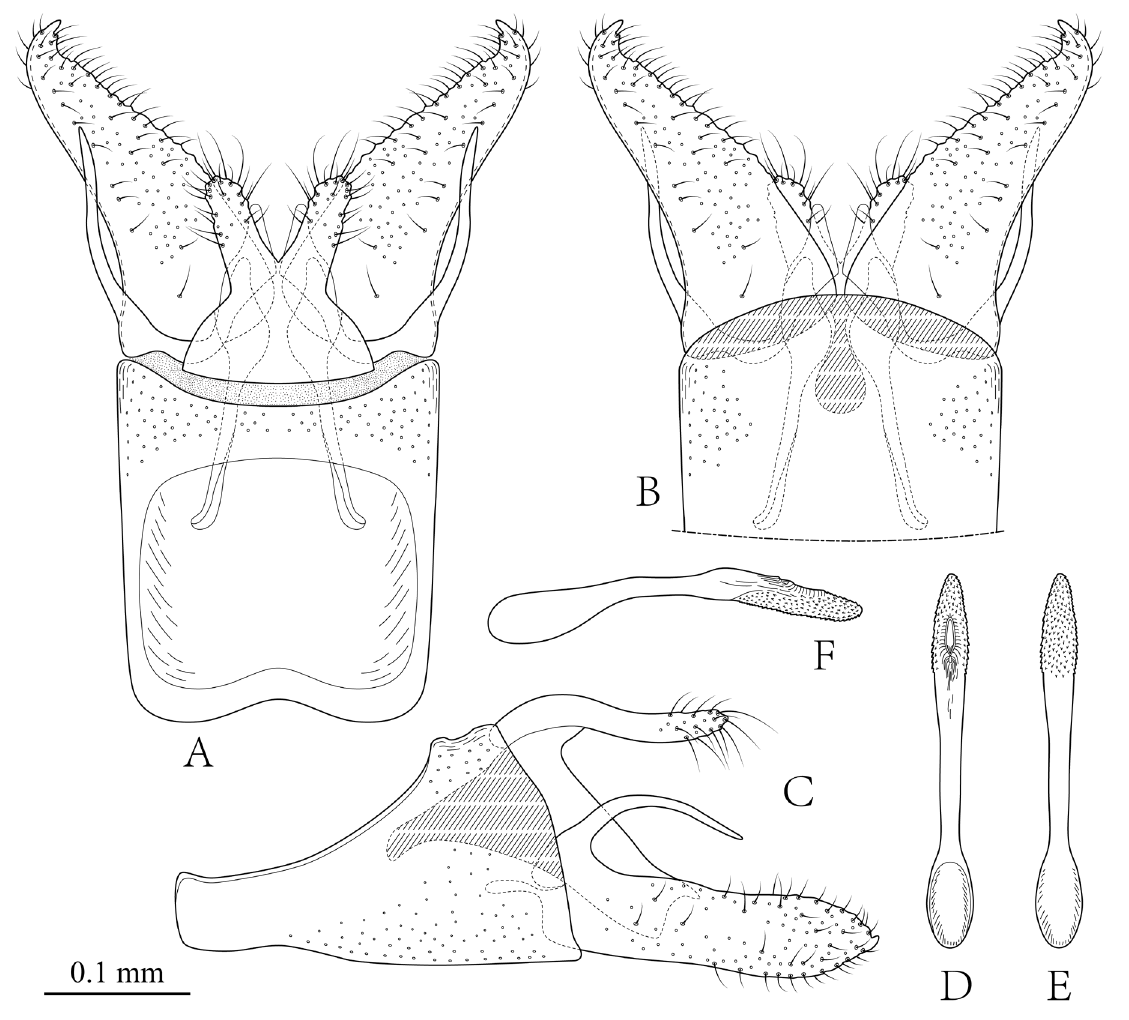
Fig. 4. Male genitalia of Vietomartyria maoershana sp. nov. A . Dorsal view, with phallus removed. B . Ditto , ventral view. C . Ditto , lateral view. D . Phallus, dorsal view. E . Ditto , ventral view. F . Ditto , lateral